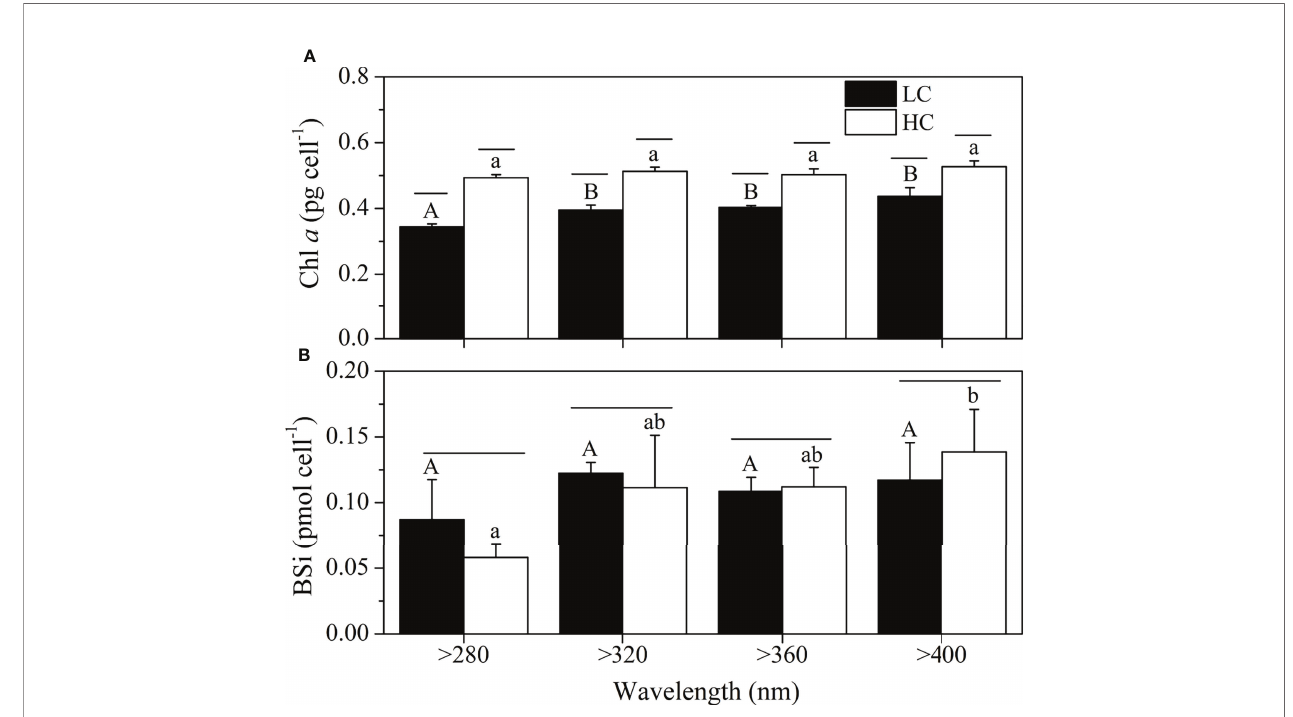
FIGURE 5 | Chla (A) and BSi contents (B) of S. costatum acclimated to ambient (LC, blackbars) and elevated CO2 (HC, whitebars) in different spectral treatments. The different uppercase and lowercase letters represent signi fi cant differences between different spectral treatments under LC and HC conditions, respectively.